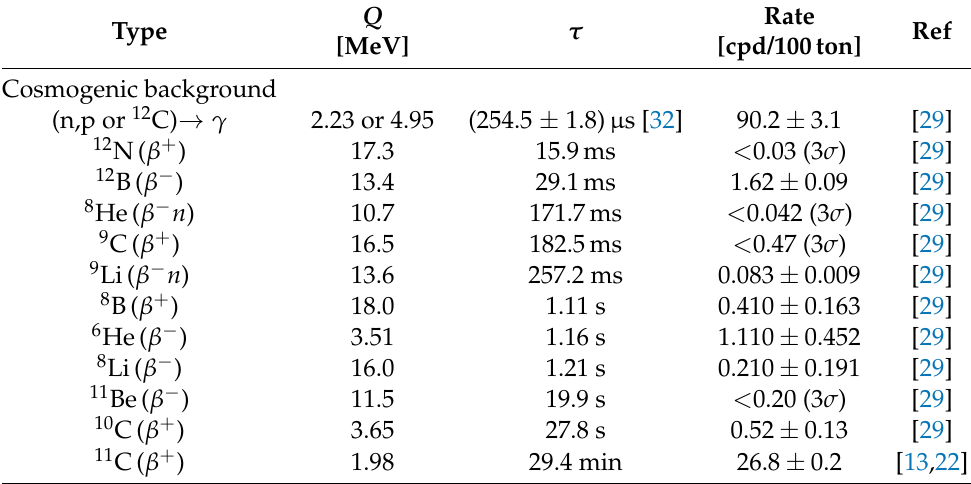
Table 2. Summary of the relevant muon-induced cosmogenic background in Borexino. The columns (from left to right) specify the isotope and its decay type, Q value, lifetime, the estimated rate expressed in counts per day per 100ton, and the corresponding reference. The rates with statistical and systematic errors summed in quadrature and 3 σ upper limits are extracted from the Borexino data through a dedicated analysis, in a scintillator mass of 99.6ton [29]. The exception is the 11 C rate that is taken from the Phase II results on solar neutrinos, measured in 71.3ton [13]. The n-capture time in Borexino was measured using the 241 Am- 9 Be neutron calibration source